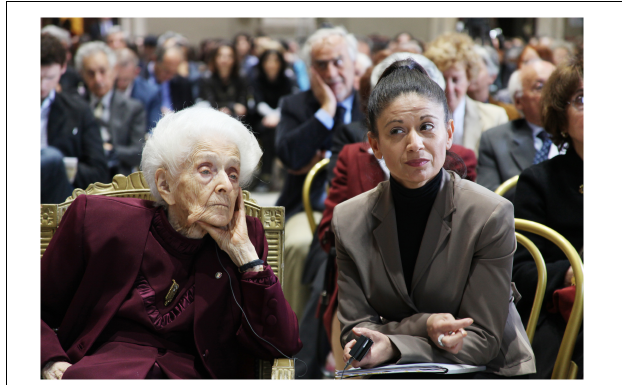
FIGURE 7 | Rita Levi-Montalcini with her assistant Pina Moliterno, during the workshop “The Brain in Health and Disease,” held in the Campidoglio, Rome, on 22nd April 2019, in celebration of her 100th birthday (EBRI Media